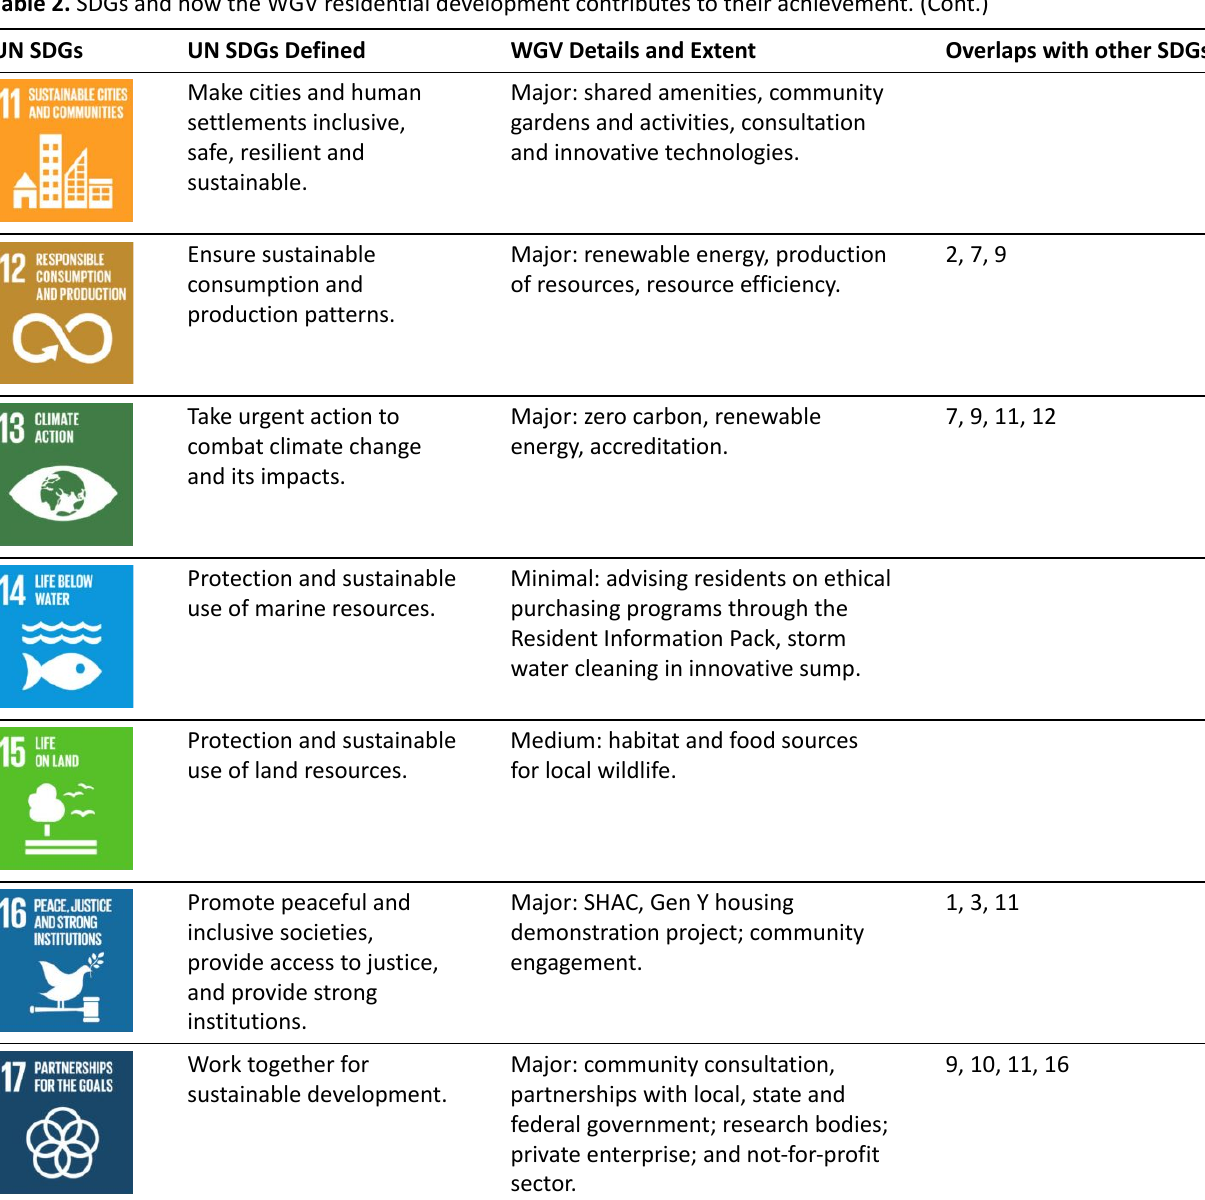
Table 2. SDGs and how the WGV residential development contributes to their achievement.